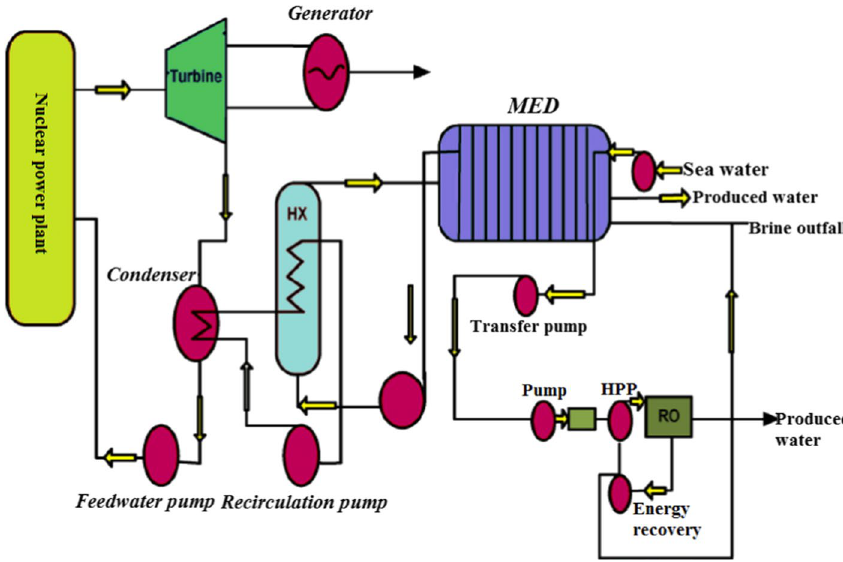
Fig. 23 Schematic of a nuclear- desalination process (Abdoe- latef et al. 2015) ( HX heat exchanger, HPP high-pressure